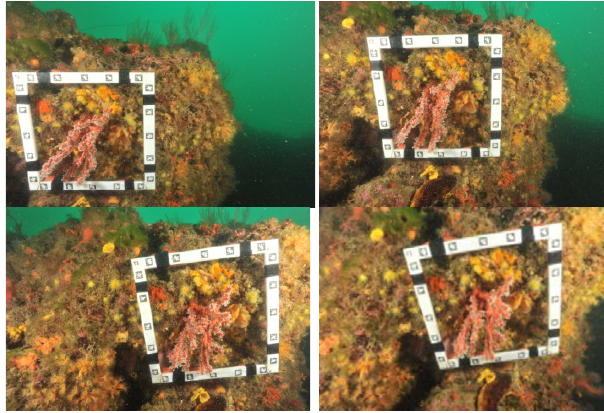
Figure 1. Four photographs taken on site showing the same small 20x20 cm zone.